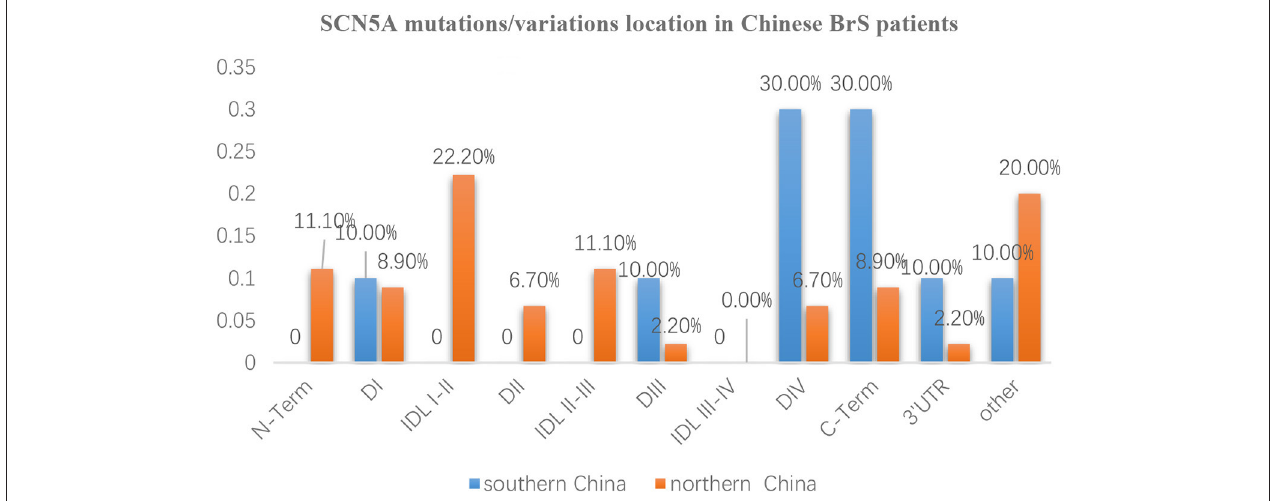
FIGURE 3 | The distribution characteristics of mutation/variation sites in different parts of the SCN5A gene in Chinese BrS patients The blue columns represent the distribution of gene mutations/variations from southern China. The orange columns represent the distribution of gene mutations/variations from northern China.